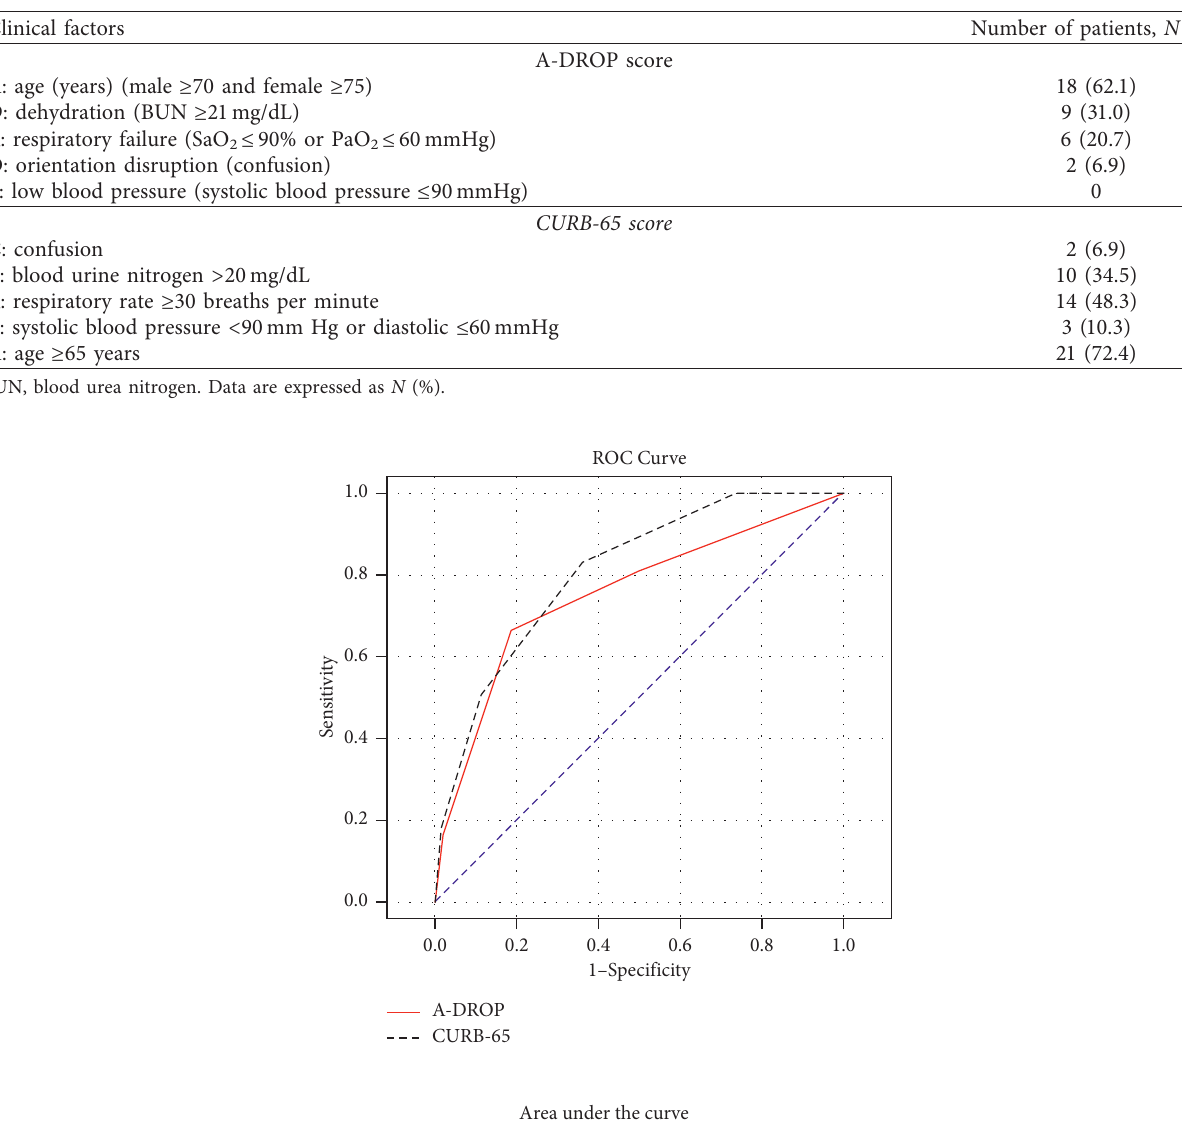
Table 3: Distribution of the revisit group based on A-DROP and CURB-65 scores.